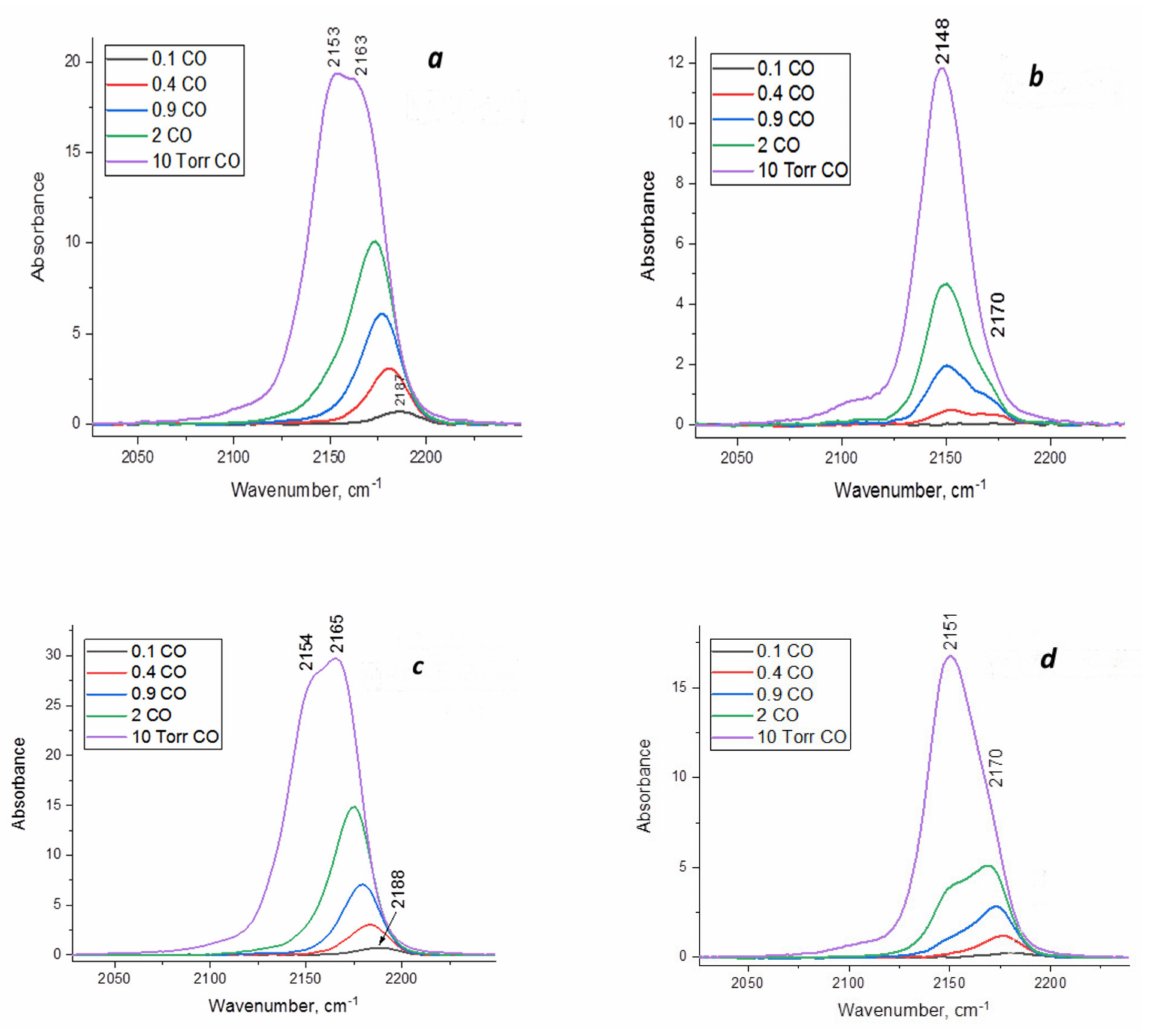
Figure 5. IR spectra of adsorbed CO on alumina-magnesia samples at 77 K and pressure in the range